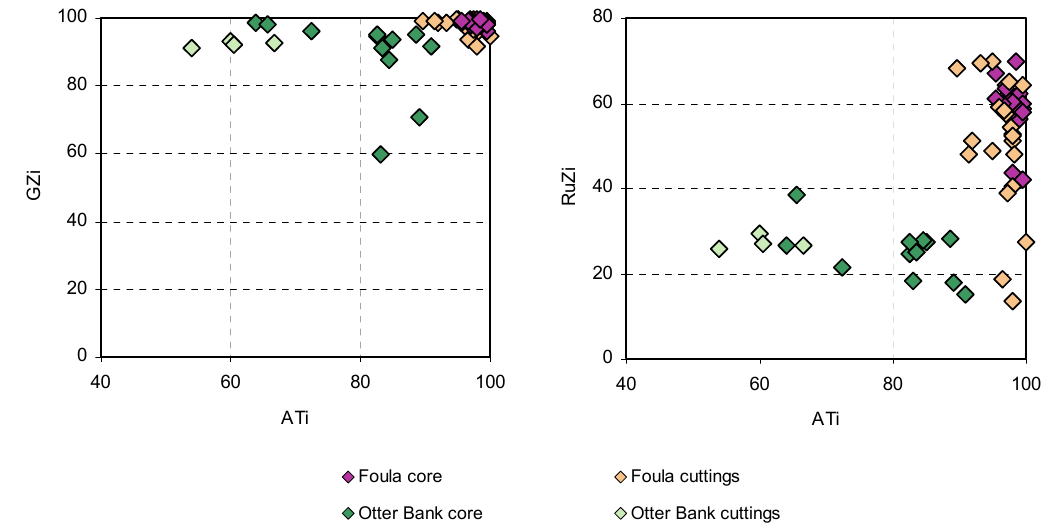
Figure 4. Crossplots of the provenance-sensitive heavy mineral ratios ATi, GZi, and RuZi showing (upper) discrimination of Foula and Otter Bank sandstones, and (lower) slight deviation in ATi between data from cores and ditch